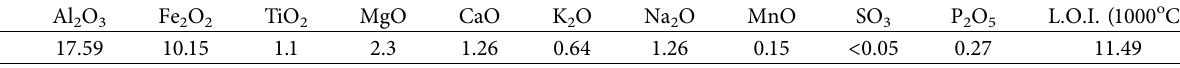
Table 1: Chemical compositions of Khulays natural bentonite (%) [14].